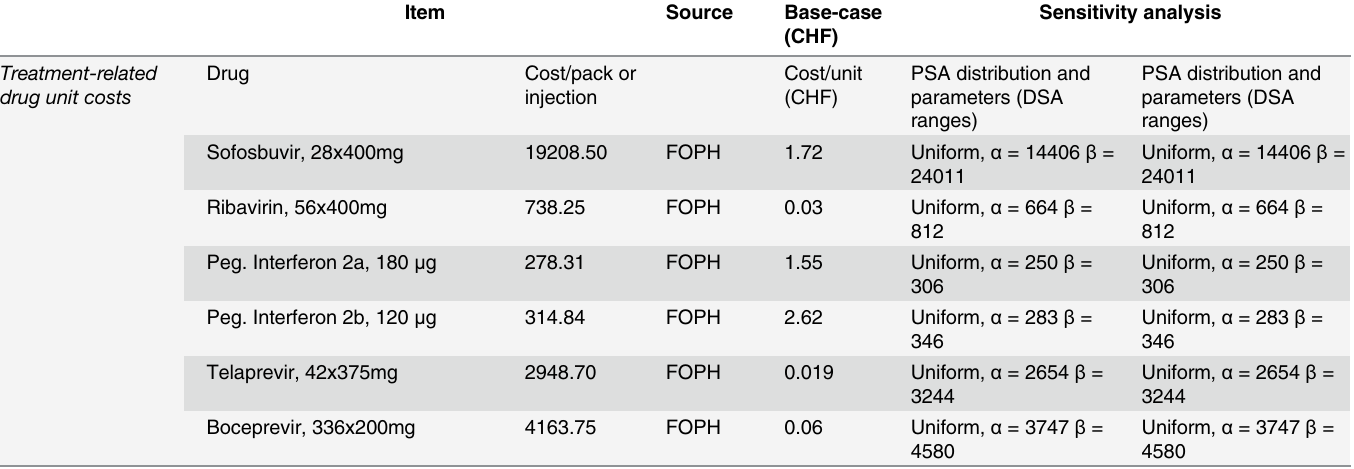
Table 3. Cost parameters and their ranges used in the deterministic and probabilistic sensitivity analyses. Item Source Base-case Sensitivity (CHF)